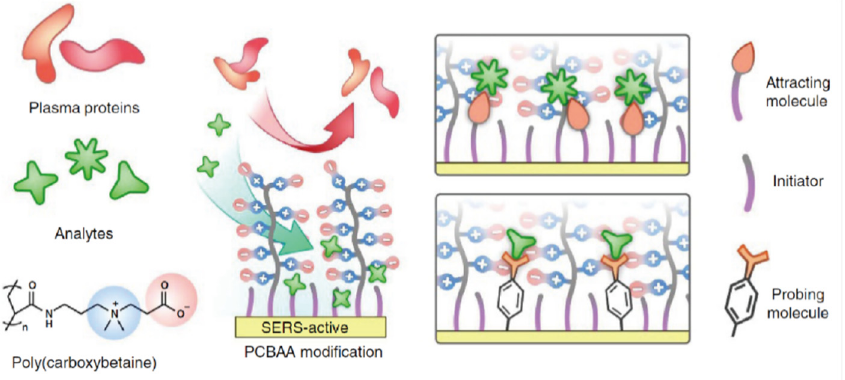
Figure 10. Schematic representation of the SERS-based protein sensor functionalized with the mixed SAM. Reproduced and adapted with permission from reference [44]. Copyright 2016 Springer Nature Limited.